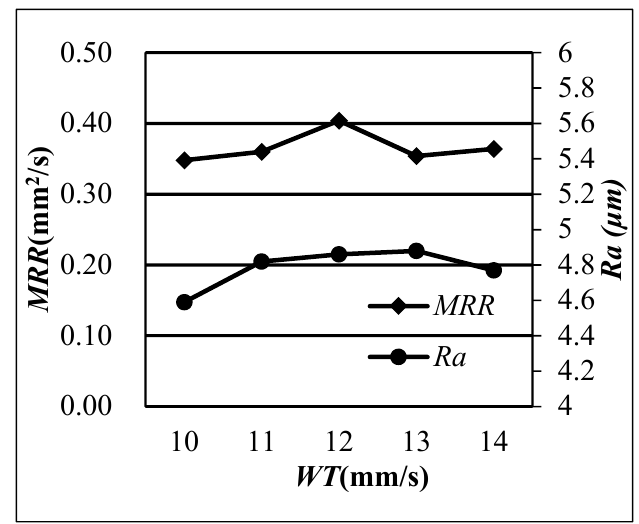
10 of 18 Figure 7. The effect of WF on MRR and SR. Figure 8 shows the effect of WT on MRR and SR . MRR is found to first increase and